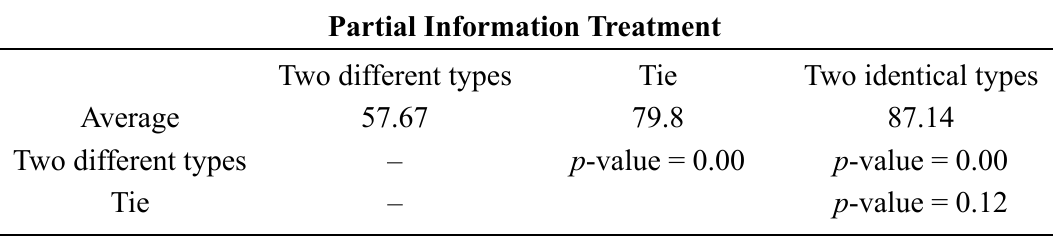
Table 6. Average frequencies of strategic votes and effect of